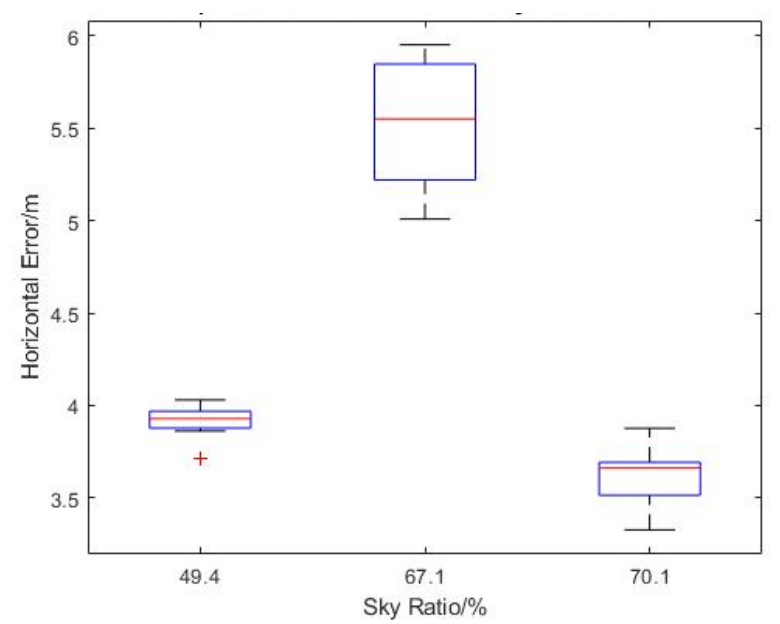
Figure 21. Graph of EPH vs. Altitude at the Admin Building.